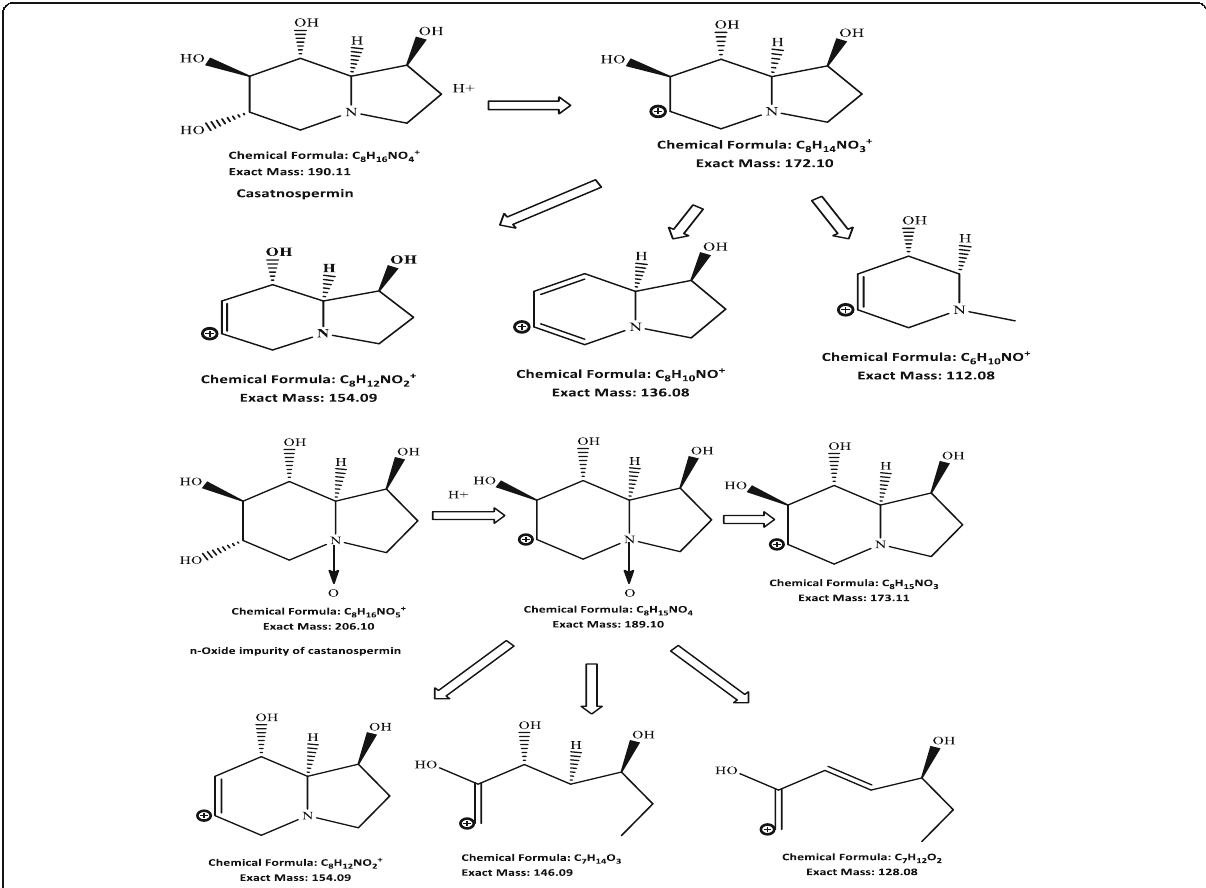
Fig. 13 Probable fragmentation pattern of celgosivir and n-oxide